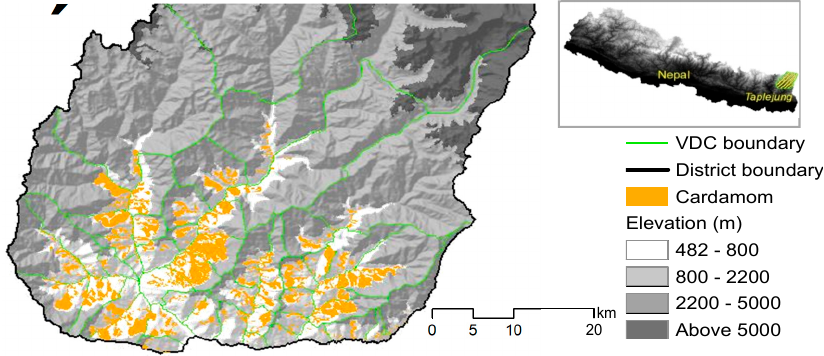
Figure 2. Mapping of large cardamom crop clusters across the Taplejung district based on participatory mapping.